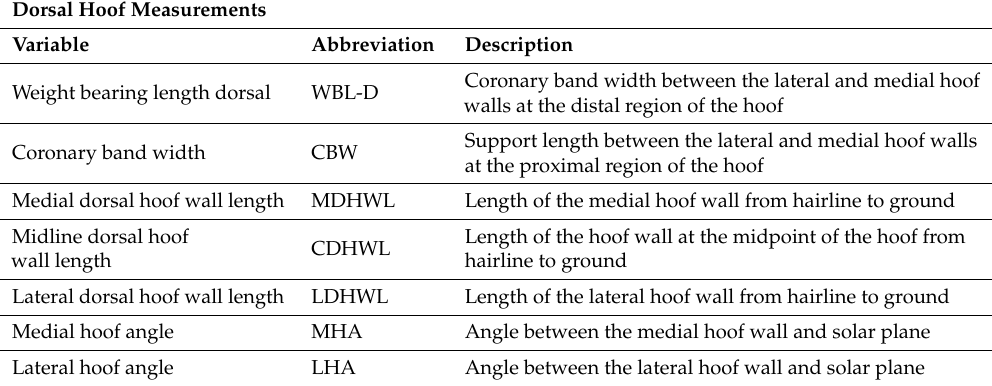
Table 3. Angular and linear morphometric variables measured from the 2D dorsal view images of the